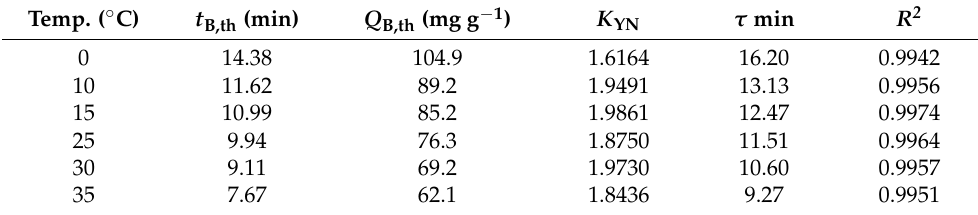
Figure 10. Influence of the presence of water on the adsorption of L2. 3.6. Recycling Performance of rGOA-1 The used rGOA-1 was recycled five times after regeneration by annealing at 80 °C for 30 min. The experimental results are presented in Figure 11, indicating that rGOA-1 possesses good regeneration properties. From Table S2, it can be observed that compared with other carbon materials, the regeneration of rGOA-1 can be achieved at a lower heating temperature, and the recovery efficiency can reach 99% without other auxiliary reagents. Although the adsorption capacity of rGOA was not high, the good regenera- tion performance determines its industrial application prospects.